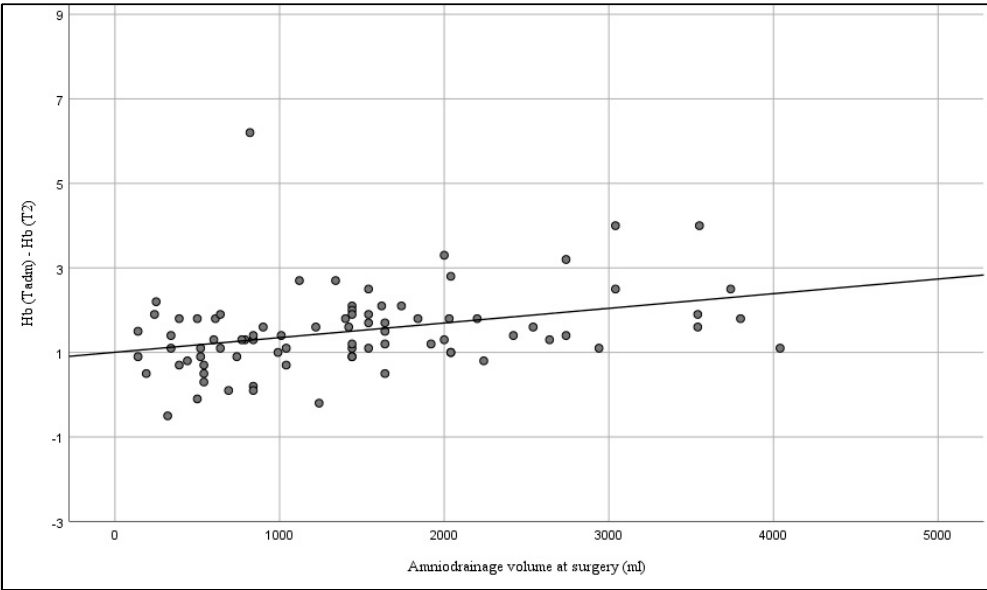
Figure 4. Correlation between the volume of amniodrainage at surgery and changes of maternal serum hemoglobin (Hb) within 24 h after the intervention (Spearman’s rho 0.379; p < 0.001).